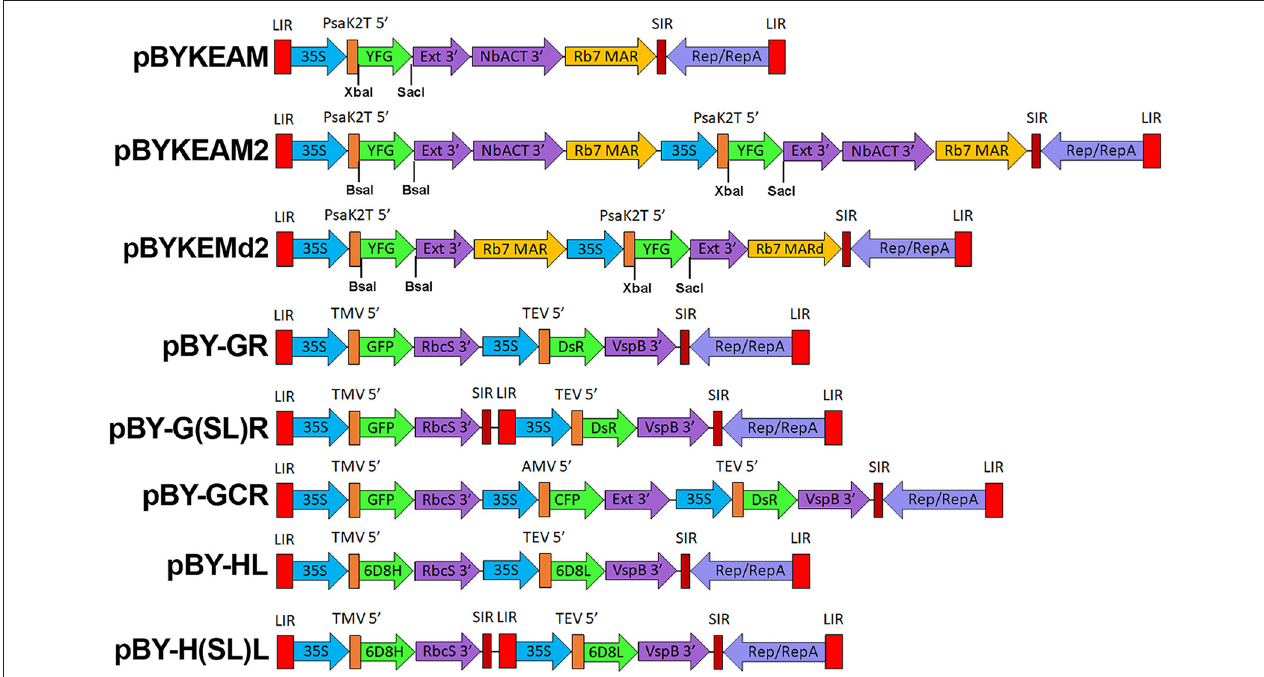
FIGURE 1 | A generalized schematic of the plant expression vectors used in this study. pBYKEAM is a replicating plant expression vector based on BeYDV with optimized 5 ′ and 3 ′ UTRs and is the vector of choice for high expression of a single target gene (Diamos et al., 2016; Diamos and Mason, 2018a; Rosenthal et al., 2018). pBYKEAM2 allows simultaneous co-expression of two genes from a single replicon containing optimized 5 ′ and 3 ′ UTRs. pBYKEMd2 is a previous iteration of pBYKEAM2 that does not contain double terminators. The remaining vectors contain multiple expression cassettes arranged as either a single large replicon or multiple replicons (when the gene cassettes are separated by SIR/LIR) with unoptimized 5 ′ and 3 ′ UTRs. For expression of antibodies, the barley alpha amylase signal sequence for ER-targeting is also present at the start of the gene. LIR, the long intergenic region from BeYDV; 35S, the 35S promoter with duplicated enhancer region from cauliflower mosaic virus; PsaK2T 5 ′ , the truncated 5 ′ UTR from the N. benthamiana psaK gene; Ext 3 ′ , the tobacco extensin terminator with intron removed; NbACT 3 ′ , the 3 ′ UTR from the N. benthamiana ACT3 gene; Rb7 MAR, the tobacco Rb7 matrix attachment region; Rb7 MARd, a truncation of the Rb7 MAR to remove unwanted restriction enzyme sites; SIR, the short intergenic region from BeYDV; Rep/RepA, the replication proteins from BeYDV; TMV 5 ′ , the 5 ′ UTR from tobacco mosaic virus; RbcS 3 ′ , the 3 ′ UTR from the pea rbcS gene; VspB 3 ′ , the 3 ′ UTR from the soybean vspB gene; AMV 5 ′ , the 5 ′ UTR from alfalfa mosaic virus; TEV 5 ′ , the 5 ′ UTR from tobacco etch virus; YFG, insertion site for the gene of interest; GFP, green fluorescent protein; DsR, DsRed fluorescent protein; YFP, yellow fluorescent protein; CFP, cyan fluorescent protein; 6D8H, the 6D8 heavy chain; 6D8L, the 6D8 light chain.